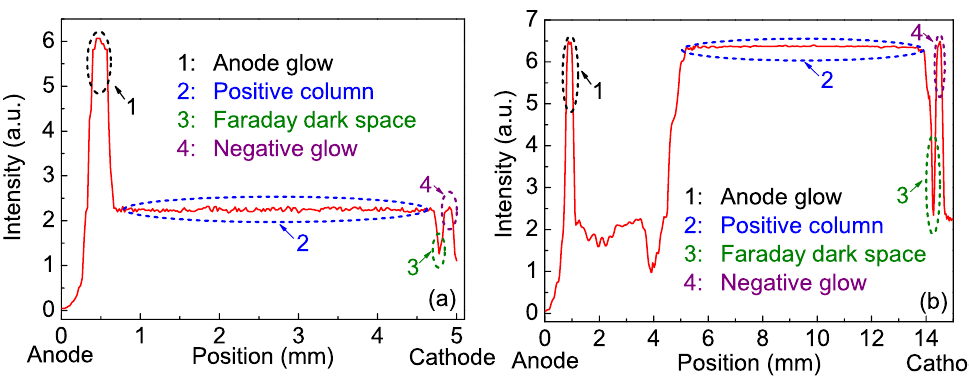
Figure 4. Spatially resolved light emission intensities along the middle discrete discharge with a gap width of 5 mm ( a ) and the symmetrical axis of the planar discharge with a gap width of 15 mm ( b